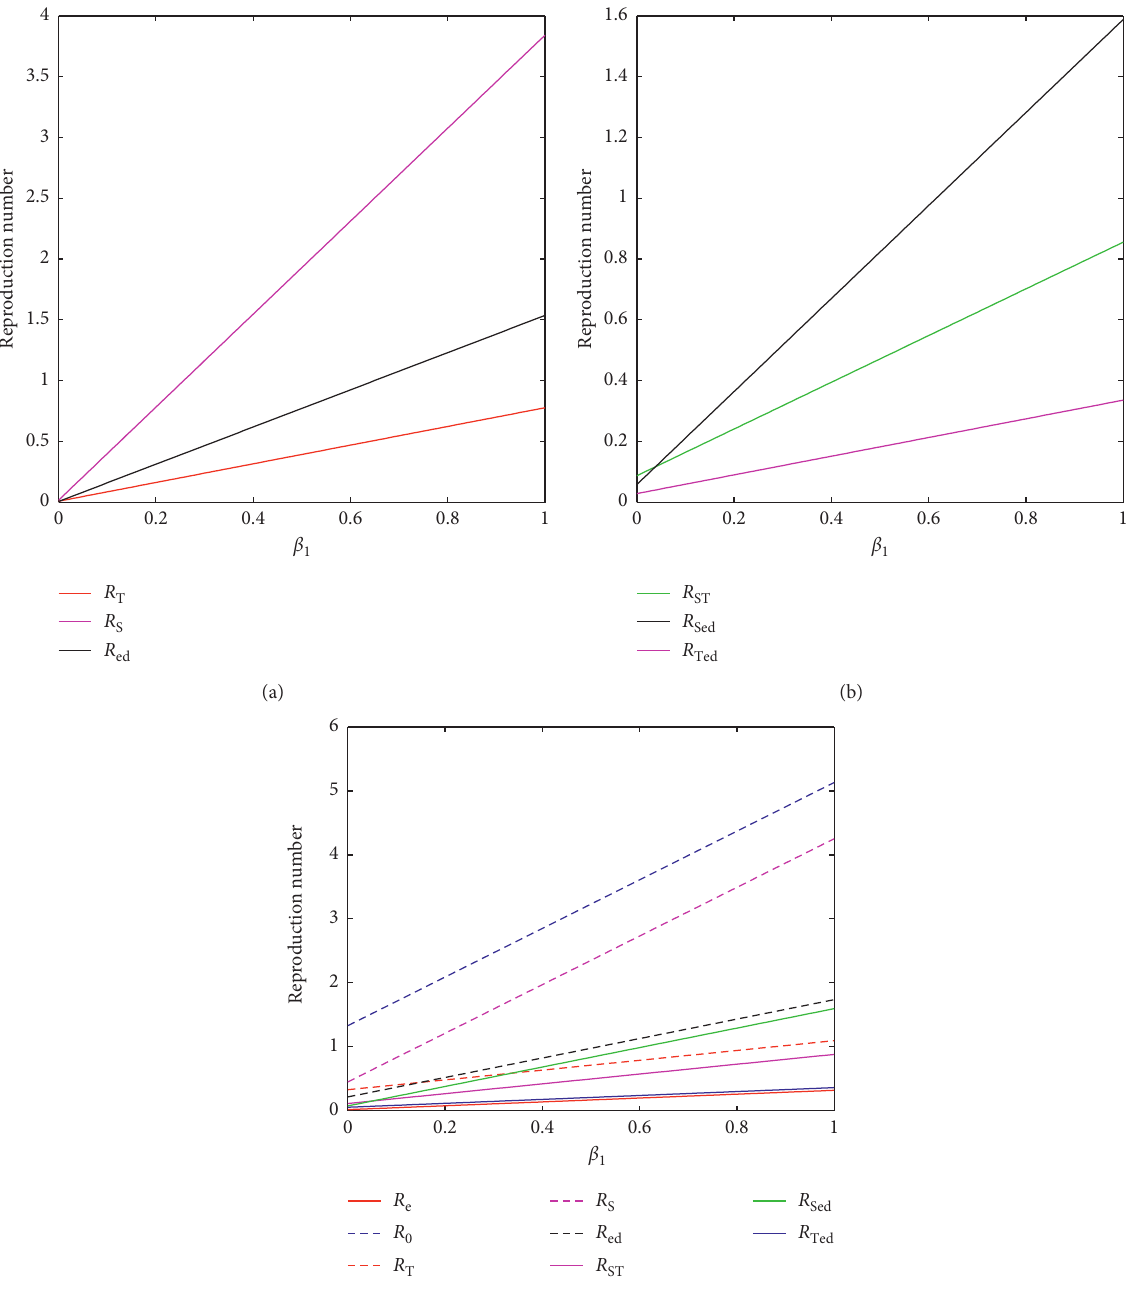
) is 0 ) has coincided with R e Ted